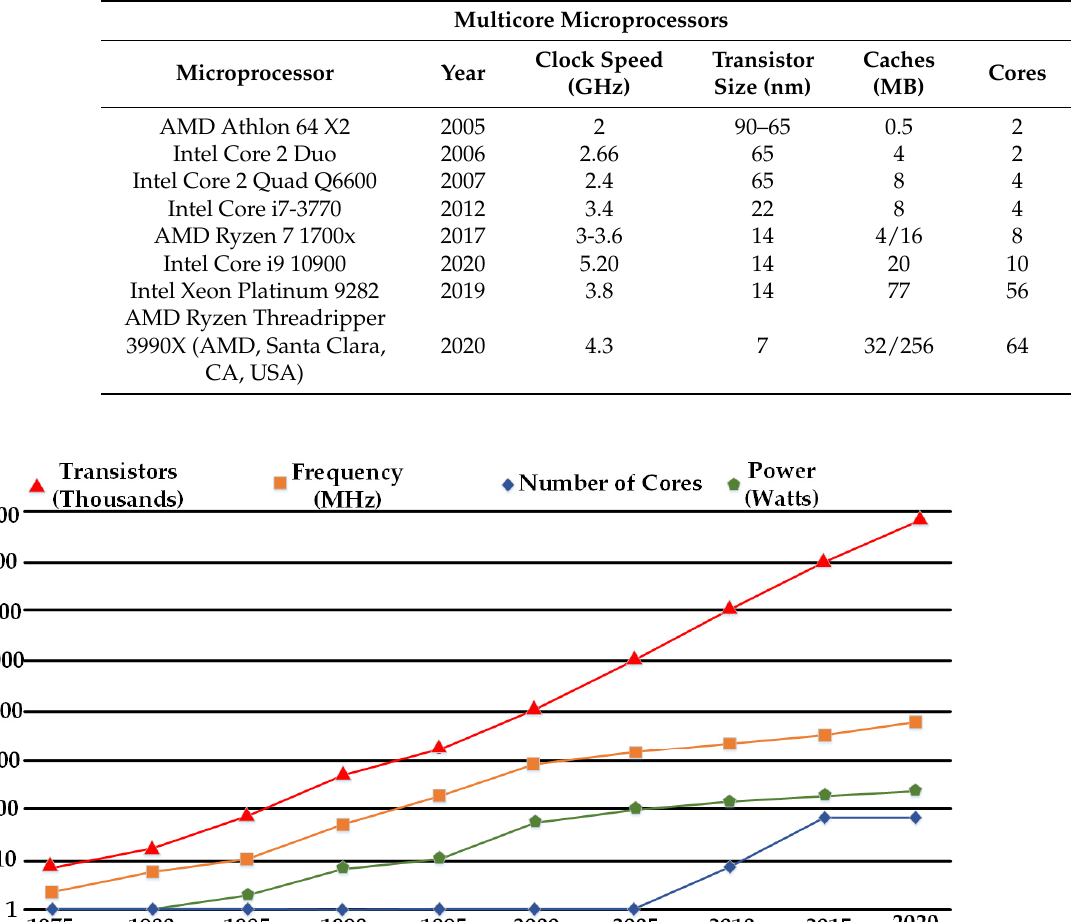
Table 2. Basic features of popular multicore microprocessors (2005 onwards).